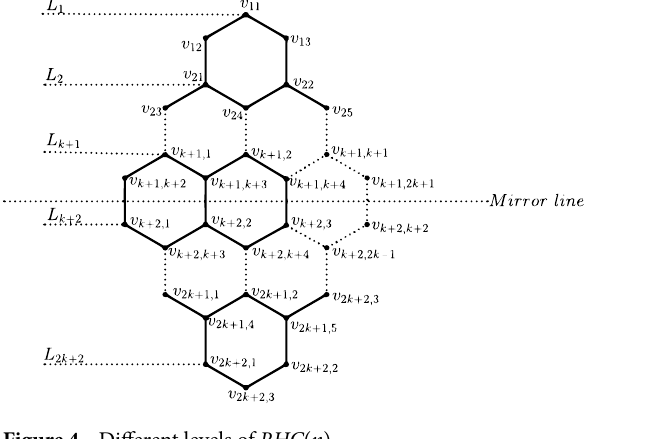
Figure 4. Different levels of RHC ( n